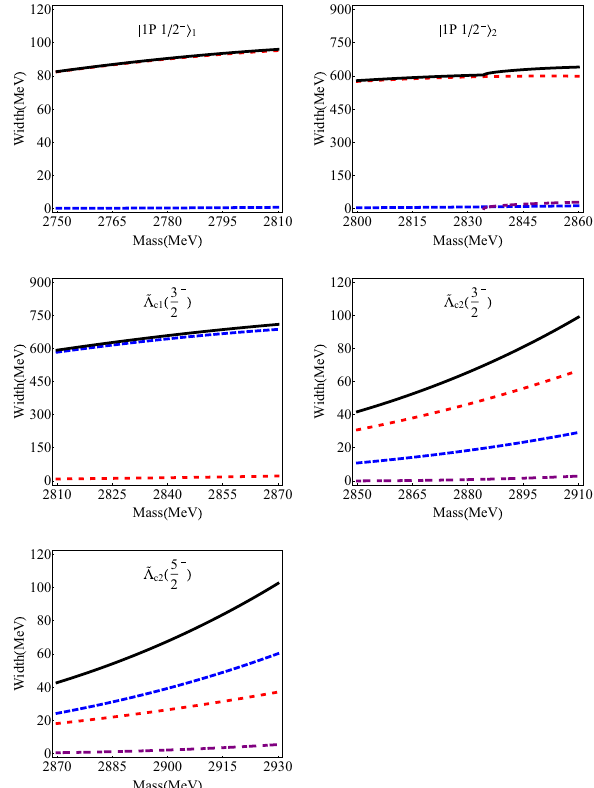
Fig. 5 The decay behaviors for the ˜ (cid:2) c ( 1 P ) states versus their initial masses. The black lines correspond to the total decay widths. The red dotted, blue dashed, purple dot-dashed lines stand for the partial decay widths of (cid:4) c π , (cid:4) ∗ c π , and (cid:2) c η channels, respectively. The (cid:2) c η mode